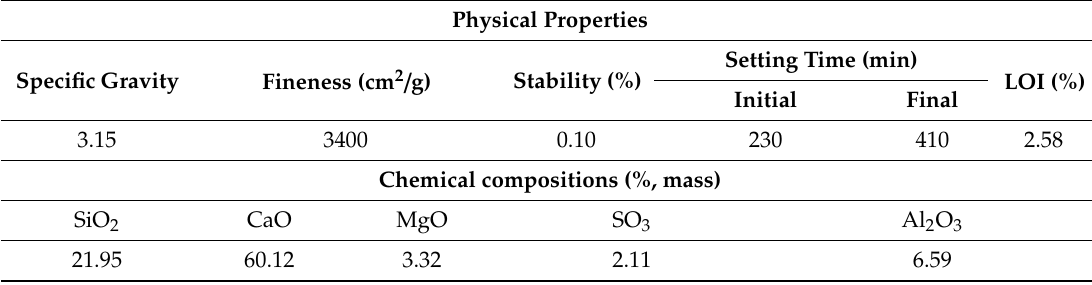
Table 1. Physical and chemical properties of the used cement.